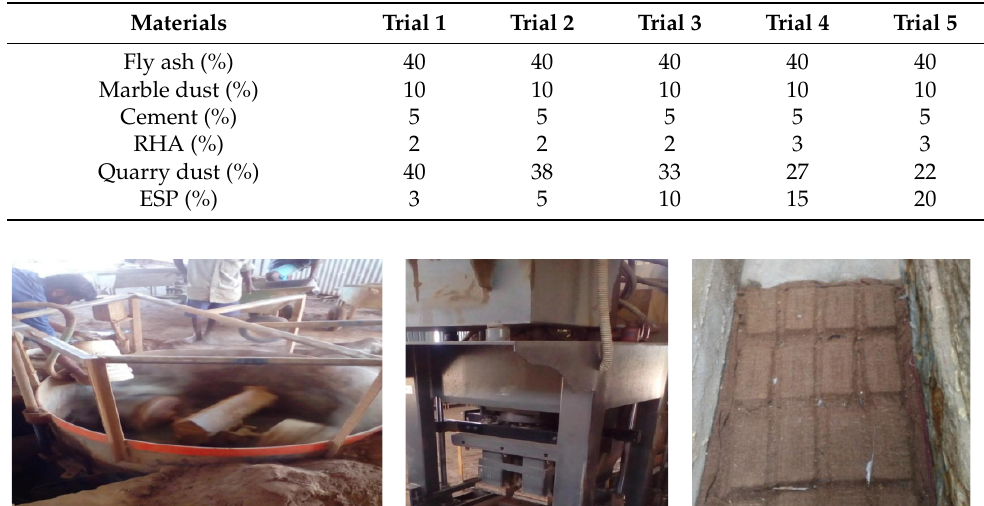
Table 2. Materials composition of various trails.